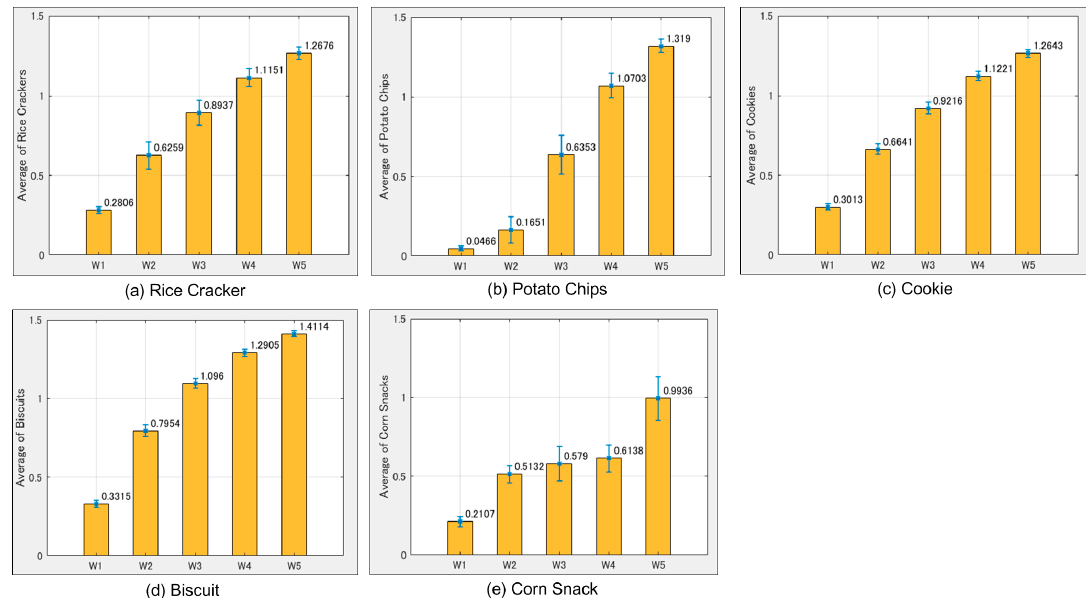
Figure 8. The average and standard deviations (STDs) of W1 – W5 for ( a ) the rice cracker; ( b ) potato chips; ( c ) cookie; ( d ) biscuit and; ( e ) corn snack.